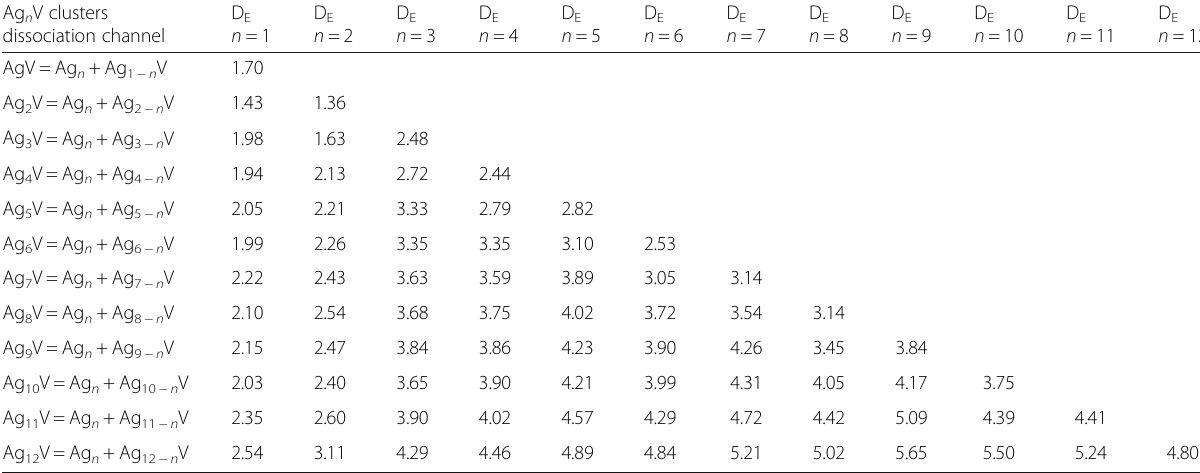
Table 4 The dissociation energy (D E , eV) of Ag n V clusters for the distinct dissociation channels Ag n V clusters dissociation channel